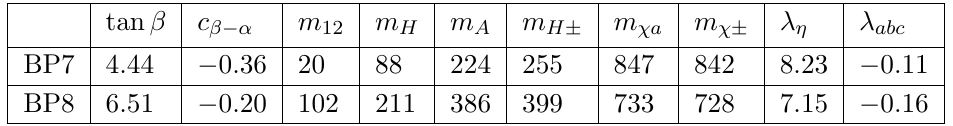
Table 3 . Benchmark points as drawn originally from the numerical scan which correspond to the curves of (cid:12)gure 10. We took the square root of the absolute value of active sector mass parameter m 12 so that a negative value corresponds to (cid:0) m 2 in the scalar potential. All mass parameters are 12 in GeV units.